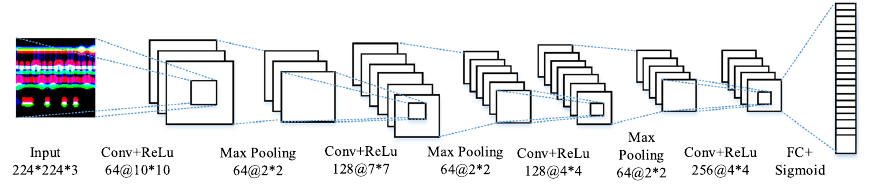
Fig. 4 Architecture of the sub-network of the Siamese neural